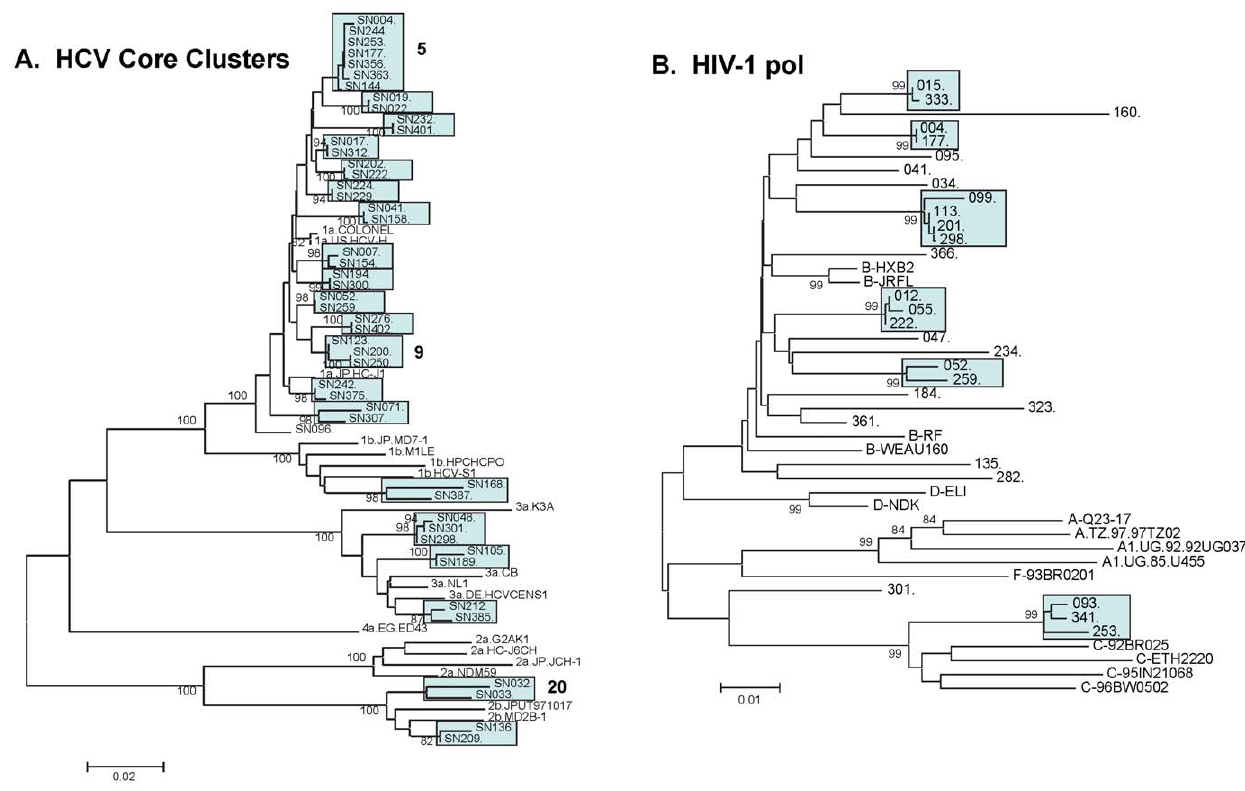
Figure 2. Phylogenetic analysis. A . Neighbour Joining analysis of all HIV-1 pol sequences generated. B . Analysis of all clustered HCV core sequences. In each tree, bootstrap values greater than 80% are indicated. In situations where HCV clusters based on core analysis (5, 9 & 20) fell below the 80% bootstrap cut off, similar analysis of NS5B (not shown) resolved clusters with bootstrap values above 80%. doi:10.1371/journal.pone.0022245.g002 PLoS ONE |